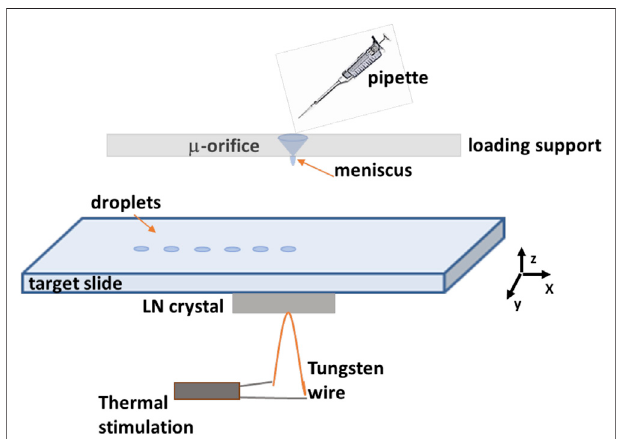
FIGURE 1 | The schematic shows the p-jet con fi